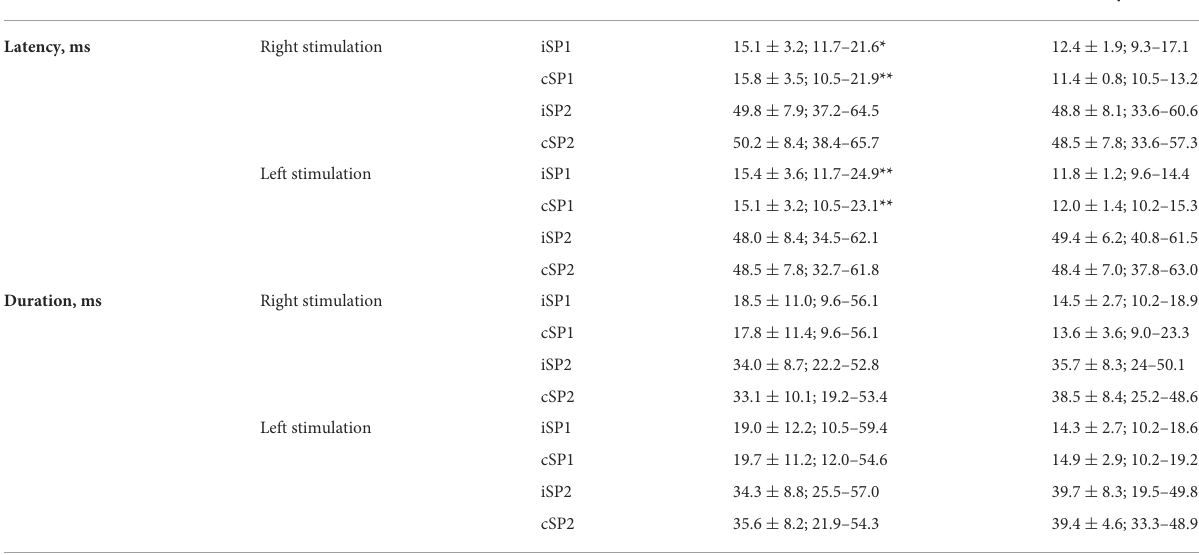
TABLE 2 Findings from the masseter inhibitory reflex in COVID-19 patients and healthy subjects.